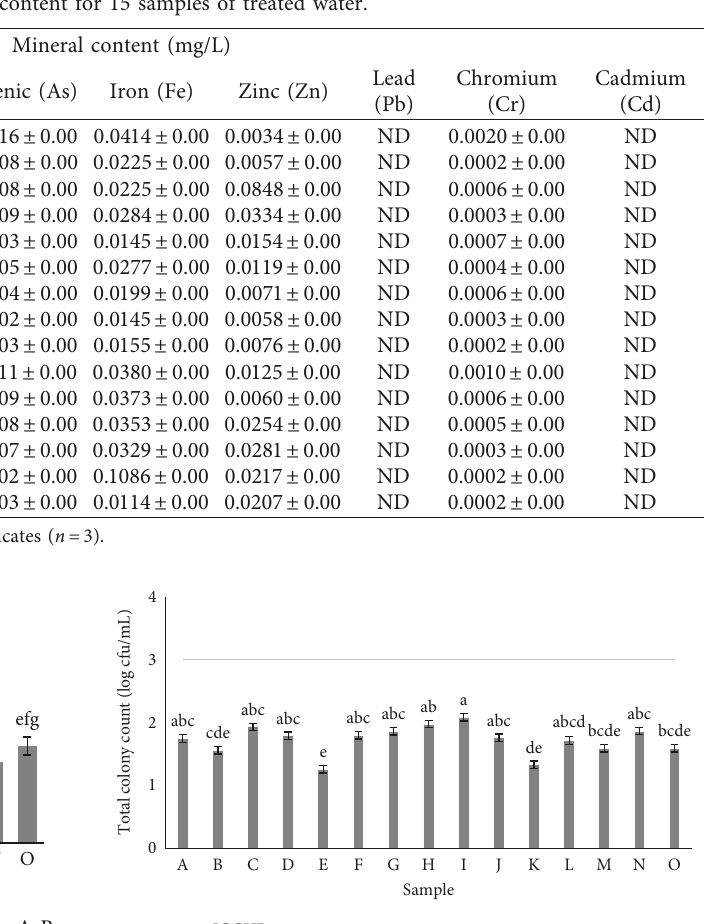
Figure 5: Dissolved oxygen for 15 samples of treated water. A-B: Sg. Ramal ; C-E: Section 8, Bandar Baru Bangi ; F-I: Section 16, Bandar Baru Bangi ; J, K, and O Section 3, Bandar Baru Bangi ; L-N: Section 15, Bandar Baru Bangi . a-g Values for the samples which have different letters are significantly different ( p < 0 . 05).